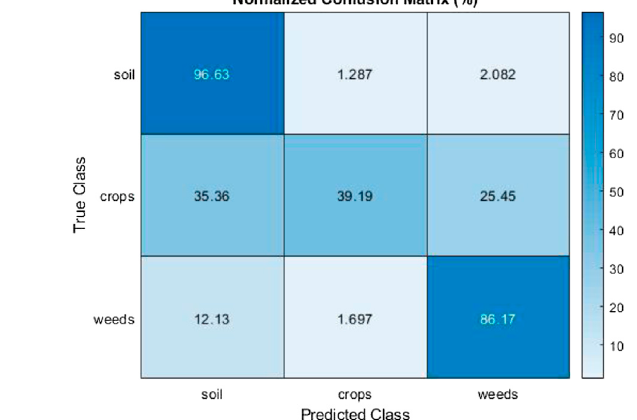
TABLE 2 | Confusion matrix of U-Net classi fi cation for sugarcane